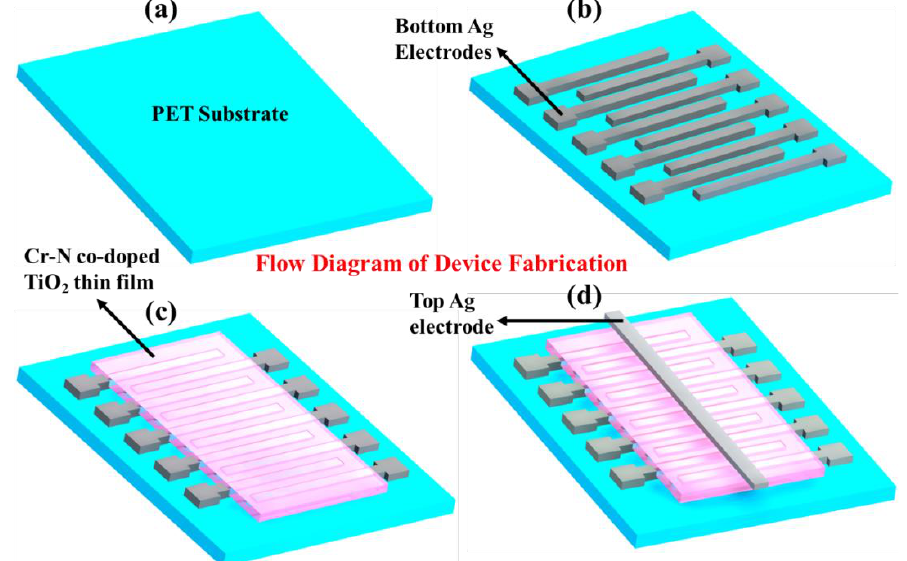
Figure 1. Flow diagram of Cr-N doped TiO 2 NPs memristor. ( a ) Flexible and transparent bare PET substrate. ( b ) Bottom Ag electrodes patterned through advanced printing technology of reverse offset. ( c ) Functional thin film of Cr-N-doped TiO 2 deposited by EHD atomization. ( d ) Final schematic diagram of doped TiO 2 memristor after patterning top Ag electrode through EHD patterning.